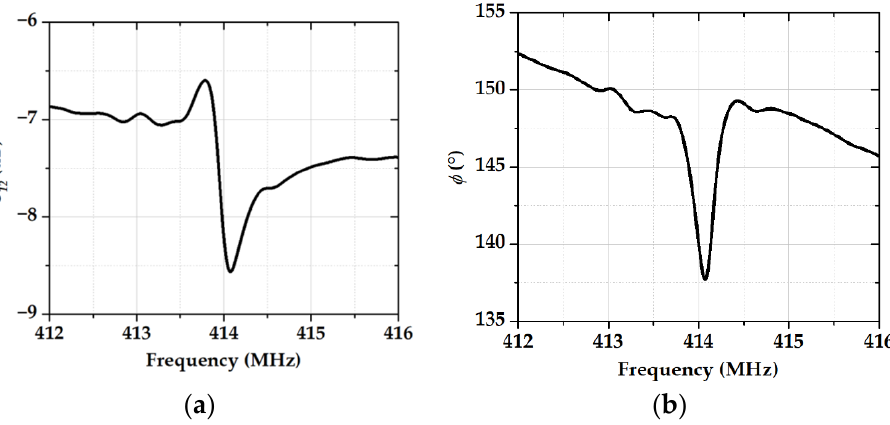
Figure 3. The frequency dependencies of ( a ) the S 12 parameter and ( b ) the phase for device #1 without sensitive film after surface plasma cleaning.